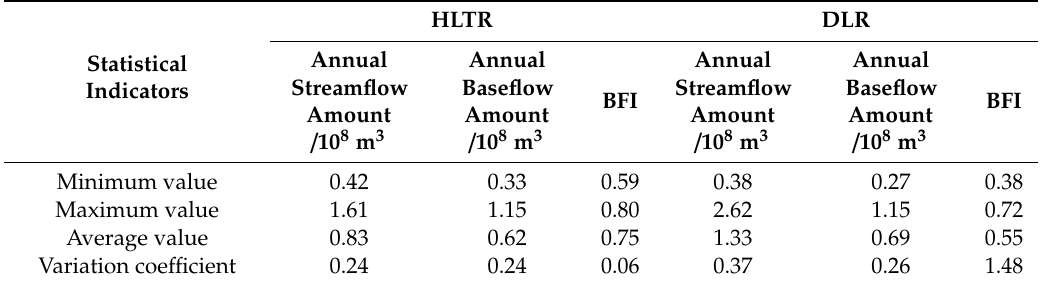
Table 1. Statistical characteristics of hydrological indicators in watersheds of di ff erent geomorphic